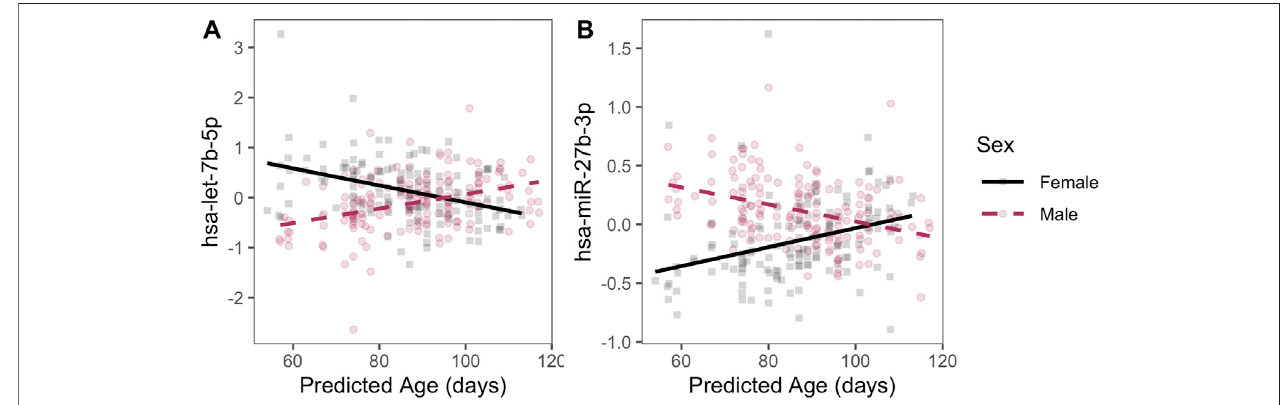
FIGURE3| Examplesofsex-speci fi ctrajectories. TwomiRNAs withstatistically signi fi cantage-by-sexinteractionsareplottedwithresidualized expression ( y -axis) across age ( x -axis) during the pseudoglandular period differs by sex (indicated by color). Residuals are displayed to illustrate sex-by-age differences after adjusting for smoke exposure, technical batch, and the four RUV-inferred covariates to emphasize patterns by age and